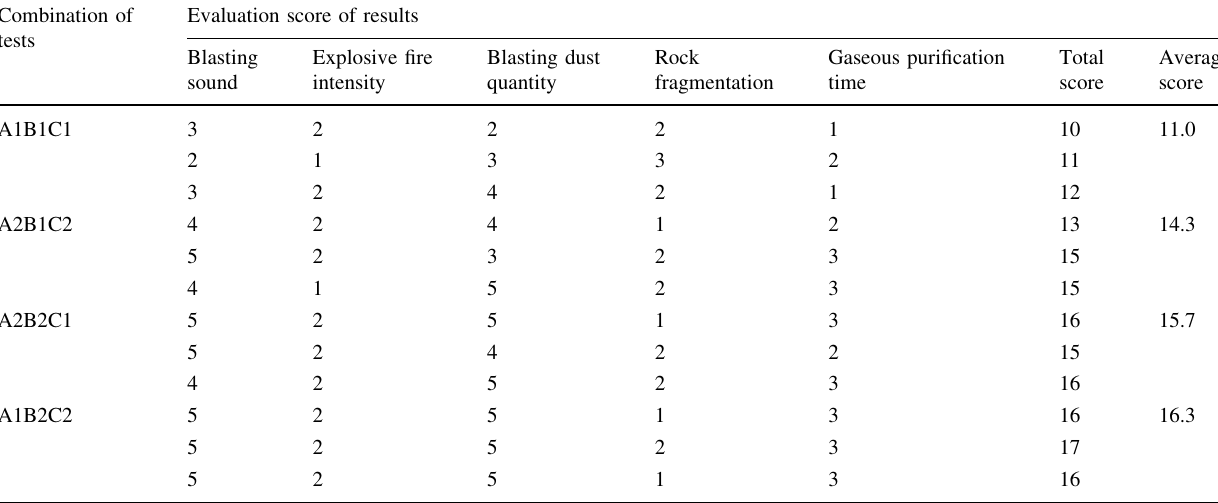
Table 4 Scoring of confined blasting test results Combination of tests